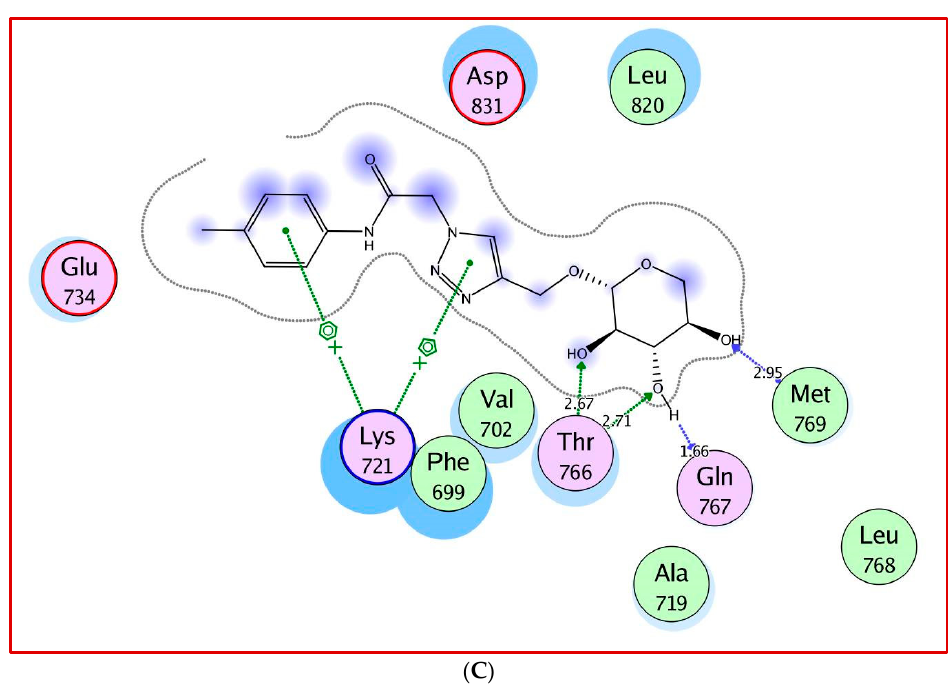
Figure 4. ( A – C ) Two-dimensional views of compounds 7 , 8 and 15 , respectively, docked in the active binding site of EGFR WT (PDB ID: 1M17) using MOE software. Within EGFR T790M (Figure 5), arene–cation interactions were illustrated between Lys745 and the indole moiety in 8 and p-tolyl in 15 . However, the triazole nitrogen and oxymethyl oxygen in 7 served as H-bond acceptors with the side chain of Ser719 (dis- tance: 3.04 and 3.24 Å, respectively).